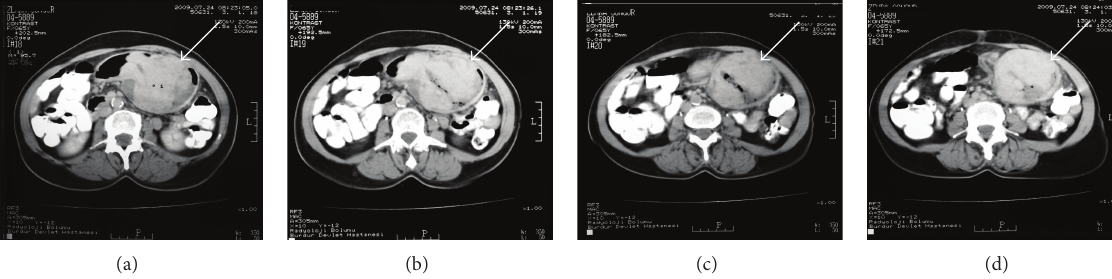
a heterogeneous hyperdense solid mass with the size of 7 , 5 × 10 ×